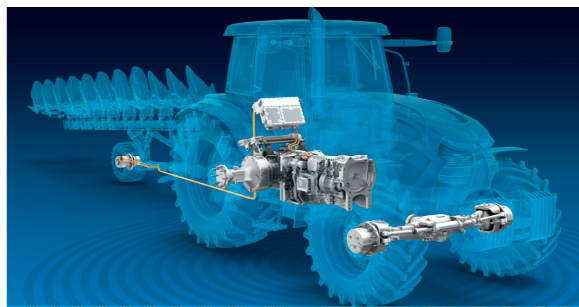
Figure 1. Schematic of agricultural tractor powertrain layout [9].